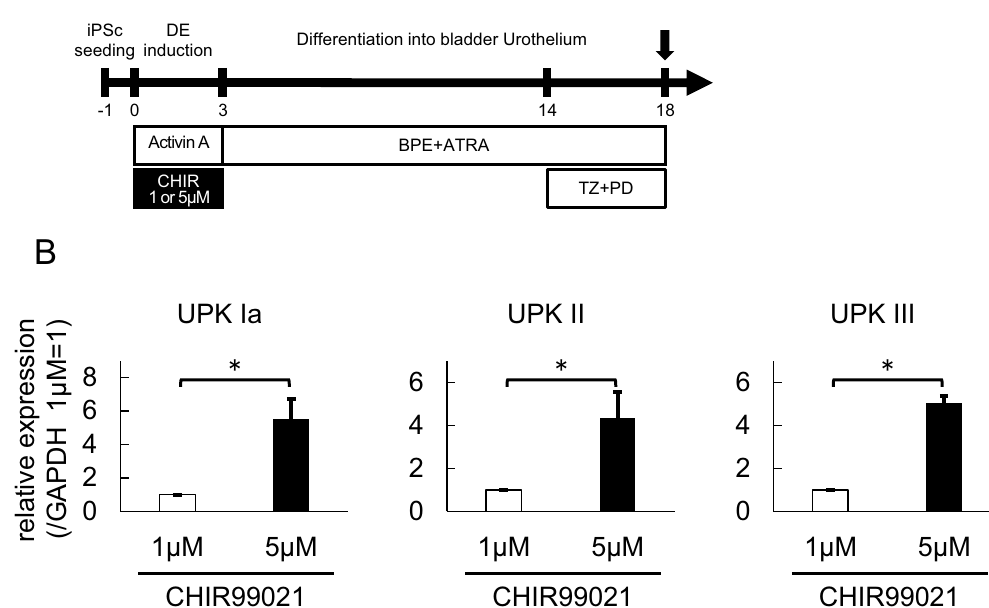
Figure 4. Treatment with a high-dose GSK3 β inhibitor during posterior DE induction enhanced urothelial differentiation. ( A ) An overview of the culture protocol for urothelial differentiation. ( B ) An expression analysis of the urothelial markers in differentiated cells treated with a high (5 µ M) or low (1 µ M) dose of CHIR during posterior DE induction by qPCR (n = 5 independent experiments; mean ± SEM). * p < 0.05; two-tailed paired t -test. Abbreviations: iPSc, induced pluripotent stem cell; DE, definitive endoderm; CHIR, CHIR99021; BPE, bovine pituitary extract; ATRA, all-trans retinoic acid; TZ, troglitazone; PD, PD153035; UPK,